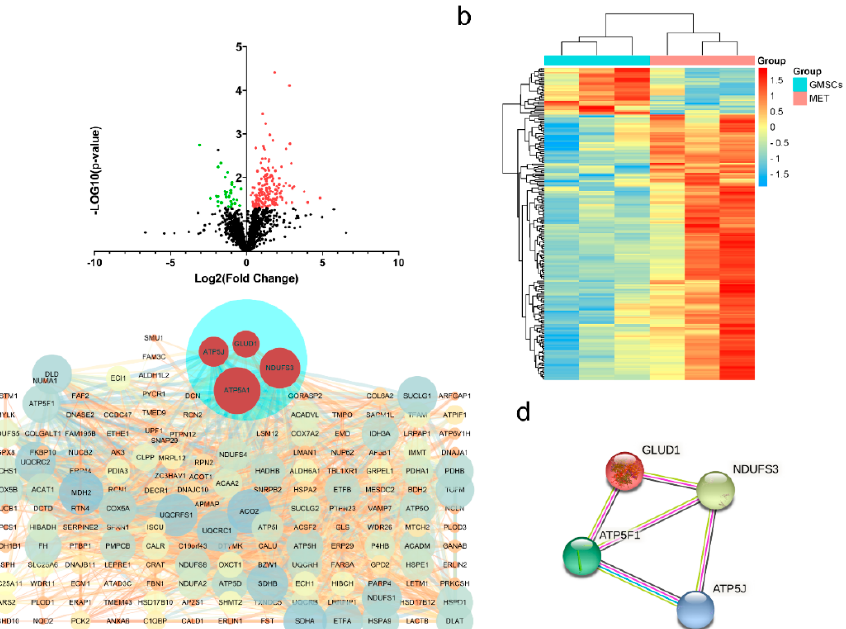
Figure 6. Quantitative proteomics and bioinformatics analysis are used to analyze the protein profile of GMSCs after neuronal induction. ( a ) The protein abundance volcano map of GMSCs cultured by neuronal induction method. The red balls represent the upregulated proteins in the induced GMSCs group, the green balls represent the downregulated proteins, and the black balls represent the proteins with no fluctuation and no significant difference. ( b ) Two hundred and fifteen differential proteins expressed by GMSCs cultured by neural induction method. ( c ) Upregulated protein–protein interaction network of proteins. Nodes represent important proteins with complex social relationships. This line represents the evidence of interaction between proteins. ( d ) A high–scoring sub–network containing four proteins.